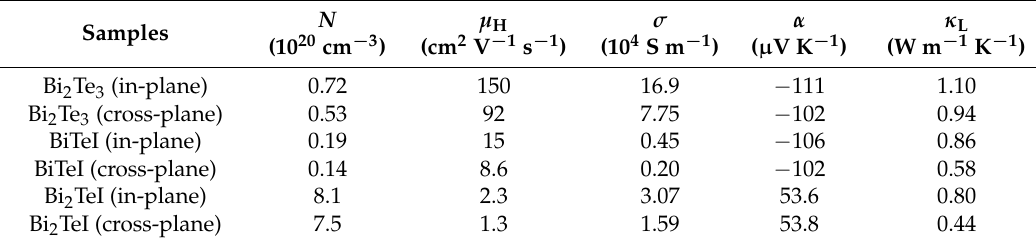
Table 1. Charge transport properties of Bi 2 Te 3 , BiTeI, and Bi 2 TeI along the in-plane and cross-plane directions at 300